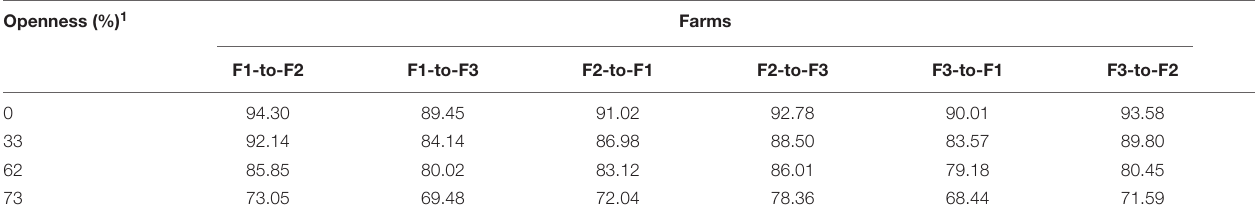
mAP Values in bold represent the best performance obtained for each class with respect to the applied models. TABLE 4 | OS* accuracy (%) of the known classes across the combination of farms, averaged over three runs on the tomato diseases dataset. Openness (%)